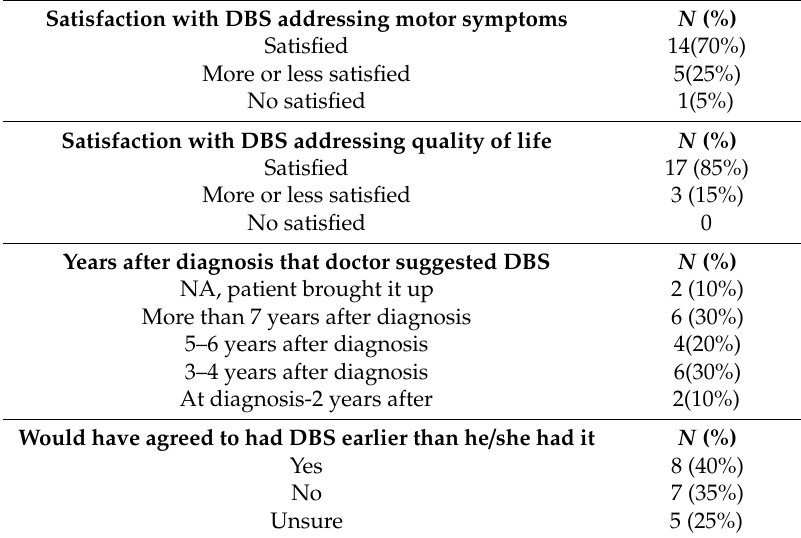
Table 2. Level of satisfaction, years after diagnosis and views on getting DBS earlier than they did. Satisfaction with DBS addressing motor